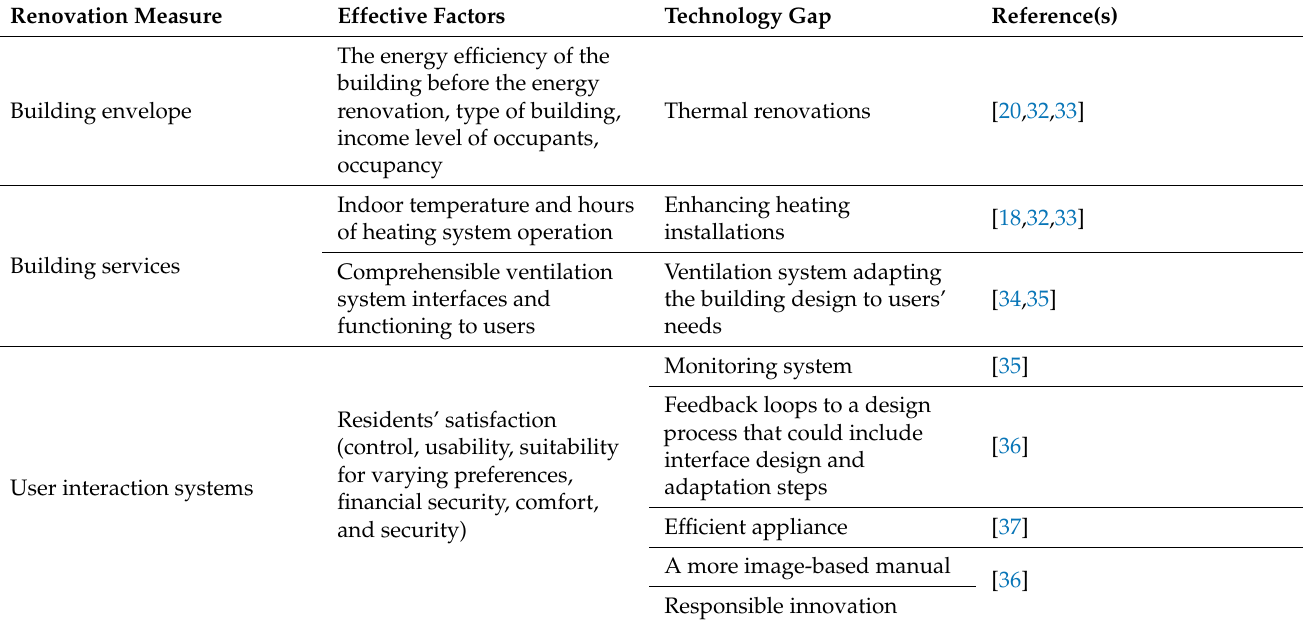
Table 2. The effective factors on energy performance gap related to the buildings’ characteristics and occupants’